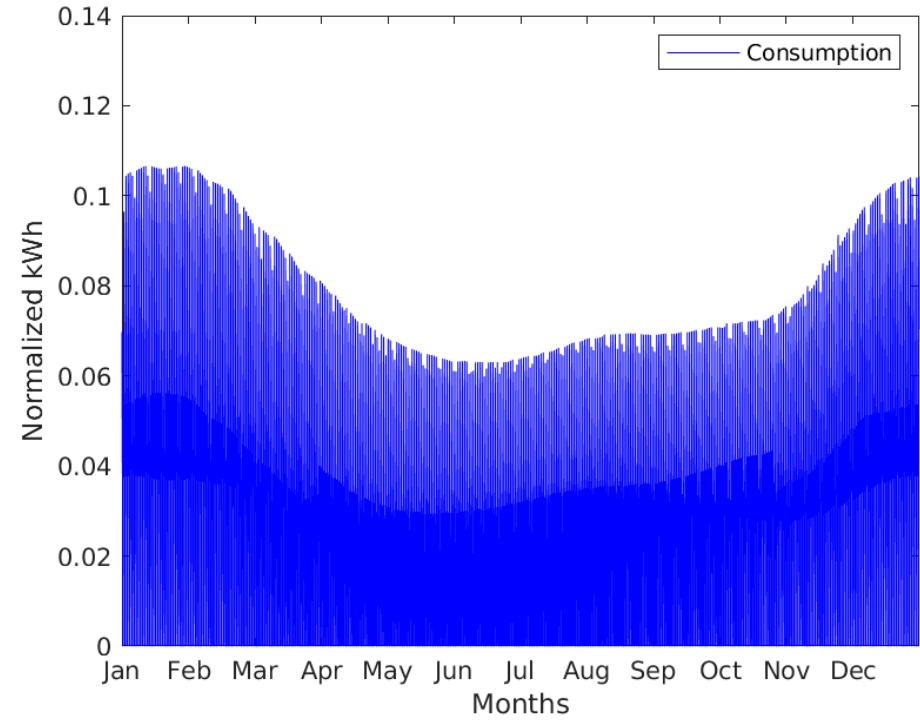
Figure 2. Normalized consumption for UPAC class C [39].